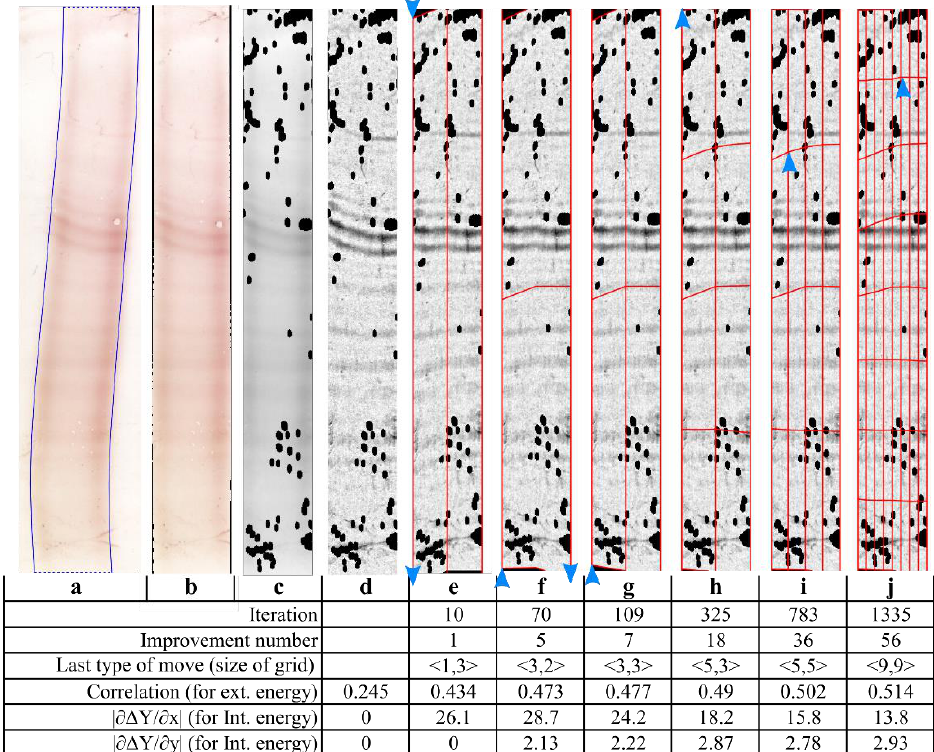
Figure 4. Illustration of the band-straightening method steps with a CSF lane: ( a ) lane segmentation, ( b ) lane straightening, ( c ) grayscale conversion and removal of unambiguous artifacts (the black zones on the lane), ( d ) Background removal (contrast ×12 for clarity), ( e – i ) are examples of intermediate steps chosen to illustrate the iterative process of band straightening with progressively finer moves (the deformed grid is superimposed on the image in red). Each blue arrow indicates the direction of the shift applied to the chosen grid point during the last iteration. ( j ) The final result.